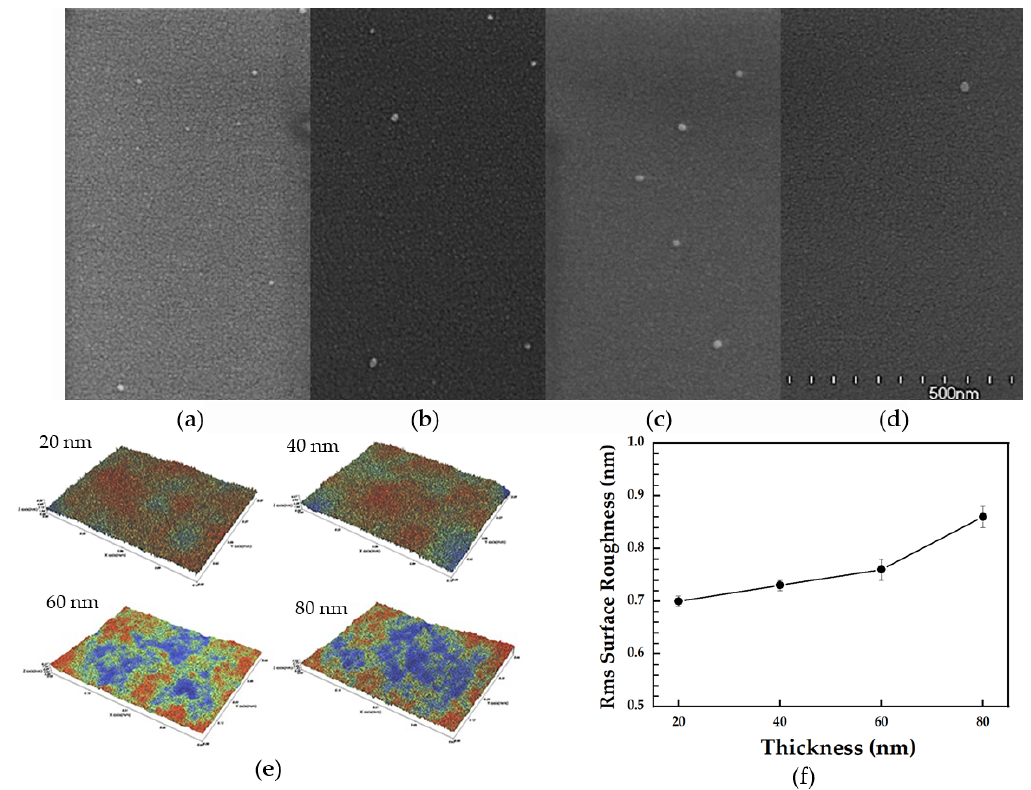
Figure 1. Field effect scanning electron microscope (FESEM) surface images of the radio frequency plasma-enhanced chemical vapor deposition (RF-PECVD) diamond-like carbon (DLC) thin films with various film thicknesses: ( a ) 20, ( b ) 40, ( c ) 60, and ( d ) 80 nm. ( e ) Three-dimensional (3D) images and ( f ) rms surface roughness of the RF-PECVD DLC thin films for the same conditions obtained by atomic force microscopy (AFM).